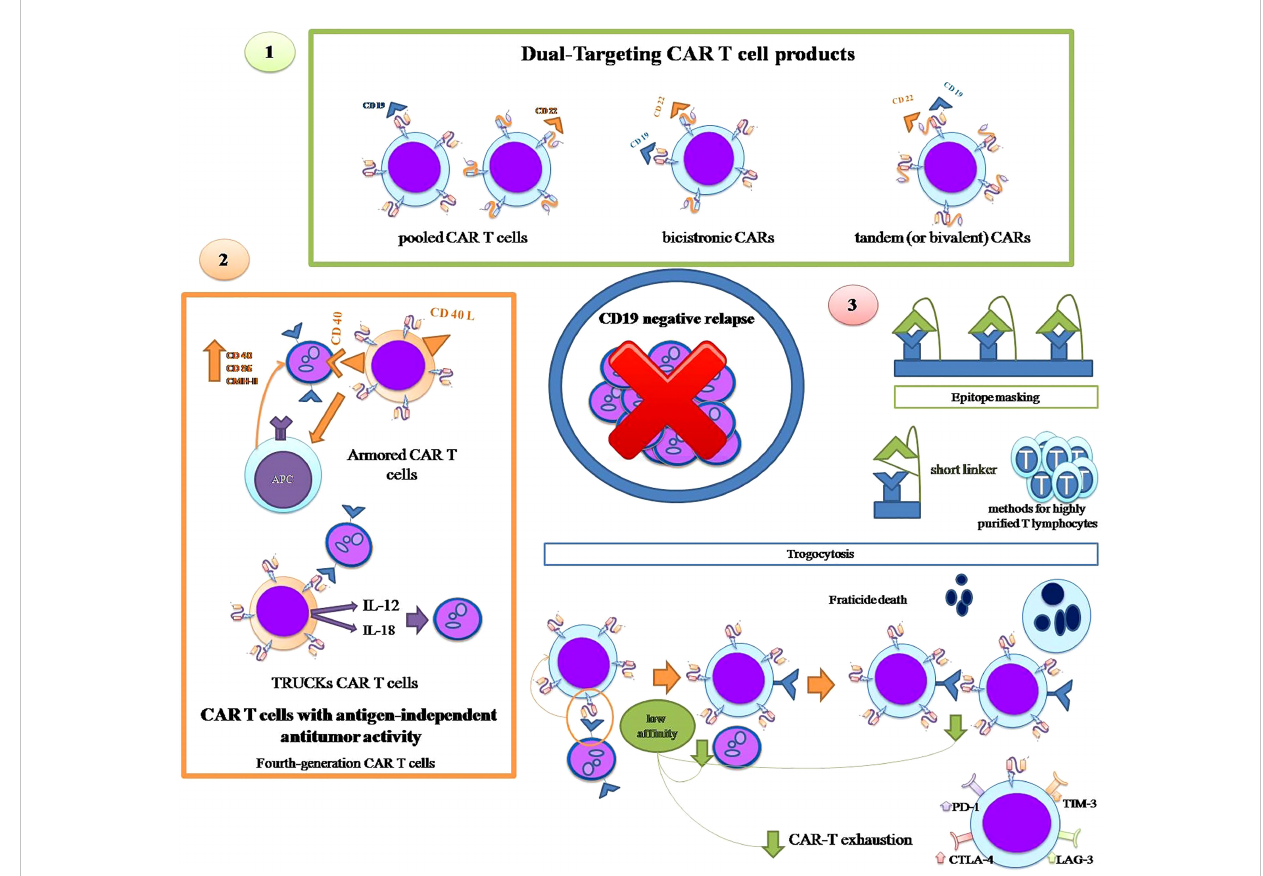
FIGURE 2 Strategies to overcome CD19-negative relapse: 1. Dual Targeting CAR-T cell products: use of pooled CAR-T cells with different unique speci fi cities, bicistronic CARs and tandem CARs. 2. CAR-T cells with antigen-independent antitumor activity: armored CAR T cells and TRUCKs CART cells. 3. Speci fi c strategies against certain mechanisms: epitope masking and